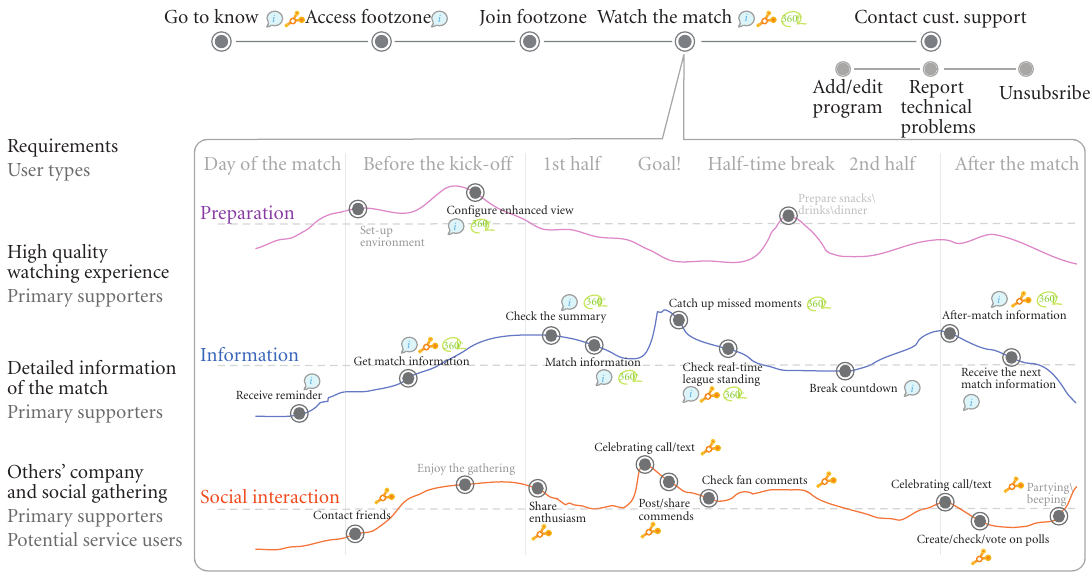
Figure 6: The activity journey